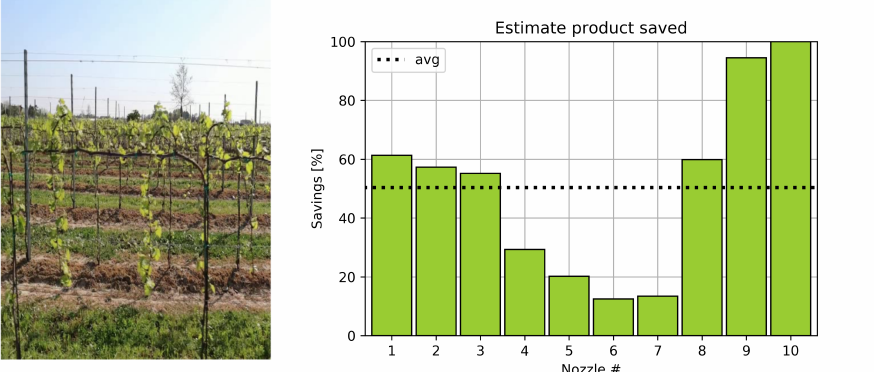
Figure 17. Percentage of closing times of each nozzle evaluated on video sequence captured in April and a sample of the relative